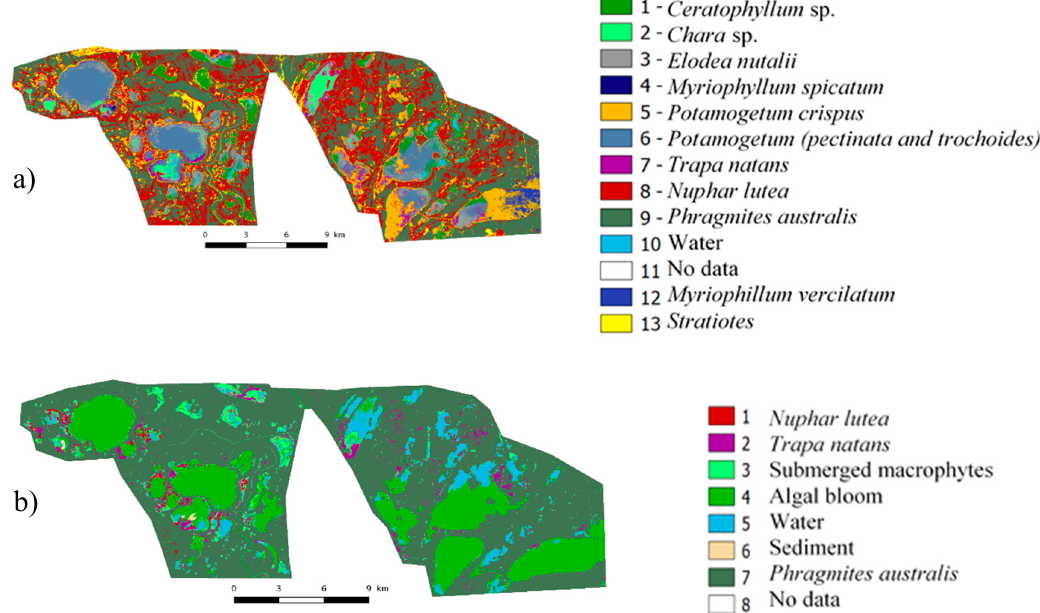
Figure 9. Macrophyte classifications for the north zone. ( a ) Classification of the S2 stack (bands and indices; 07/17/2016) with S1, in detailed nomenclature. ( b ) Classification of the Pleiades stack (bands and indices; 07/11/2017) with S1 in simple nomenclature.